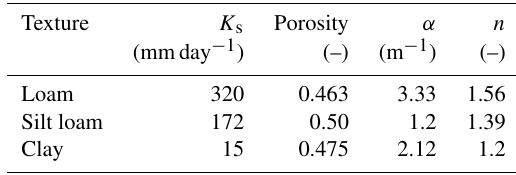
Table 2. Hydraulic properties for different soil types (refer to Fig. 1c). Saturated hydraulic conductivity ( K s ) and porosity data are obtained from Rawls et al. (1982). The Van Genuchten parame- ters are acquired from Schaap and Leij